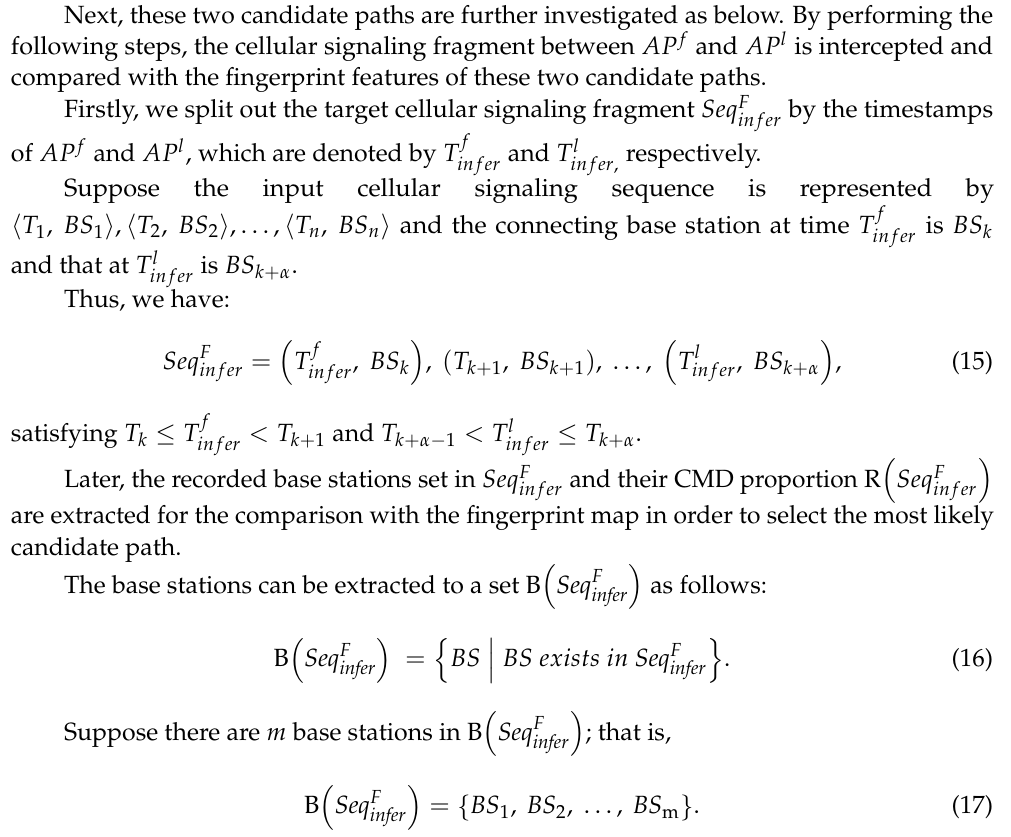
Figure 5. The orange anchor point probably has more than one matching option.